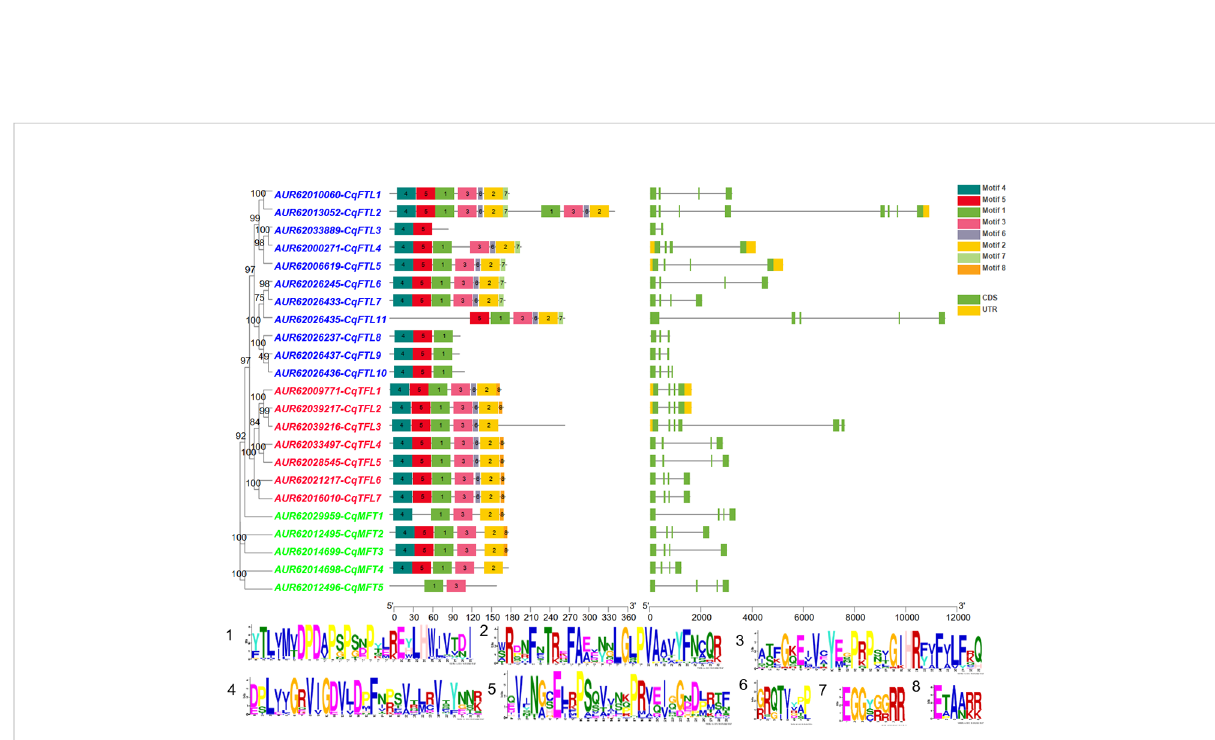
FIGURE 3 Diagram shows the conserved amino acid motifs and gene structure of PEBP genes in quinoa. The conserved motifs were identi fi ed by MEME. A total of 8 motifs were discovered among all PEBP genes. Different motifs are indicated by the colored boxes. Motif 1 to motif 5 are appeared in most PEBP proteins. Amino acid sequences of the conserved motifs are listed below. The identities of FT , TFL and MFT subclade genes are colored in blue, red and green in phylogenetic tree at the left side. Exons, introns and untranslated regions (UTRs) of PEBP genes are denoted by green, yellow boxes and dark lines,